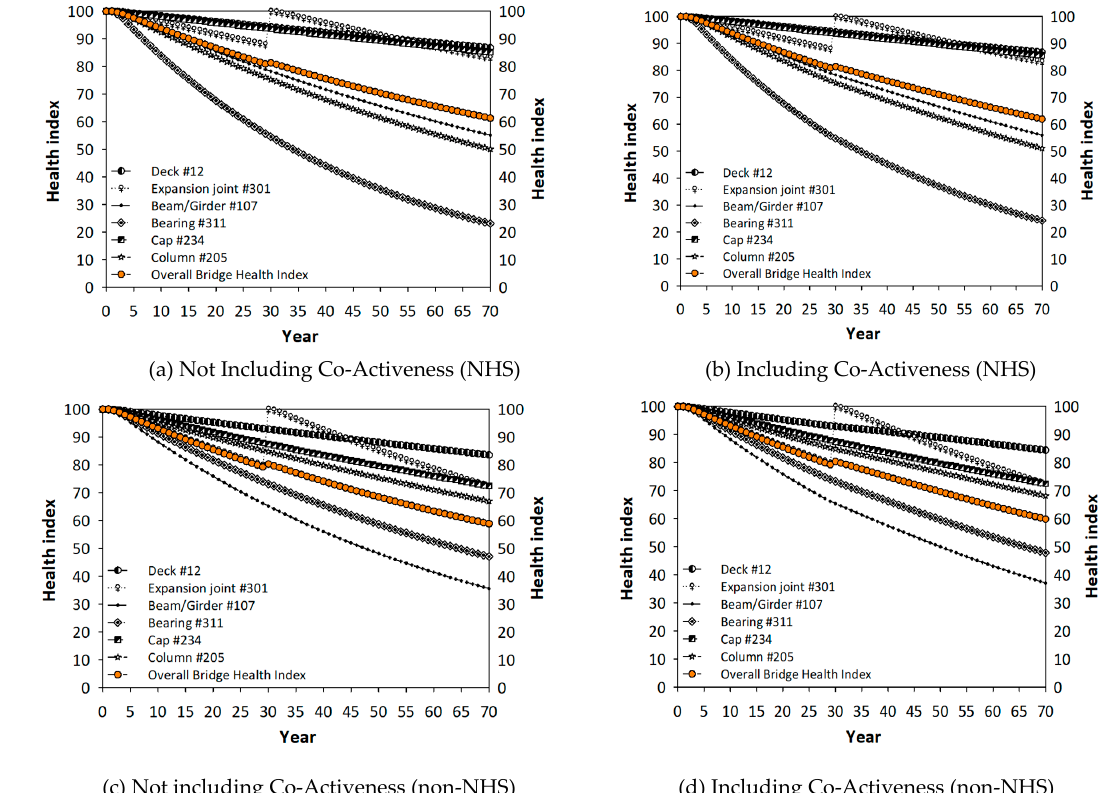
Figure 14. The effect of an expansion joint replacement not including and including the co-active mechanism: ( a ) and ( b ) in NHS Bridges, ( c ) and ( d ) in non-NHS bridges in Pennsylvania.